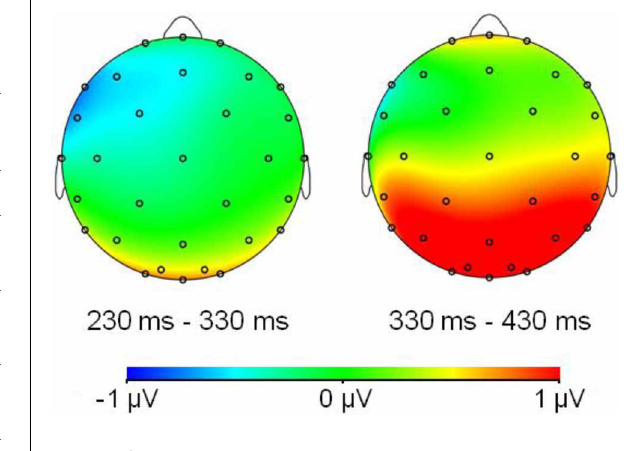
FIGURE 2 | Topographical maps of the wave difference of low-frequency word amplitudes minus high-frequency word amplitudes.